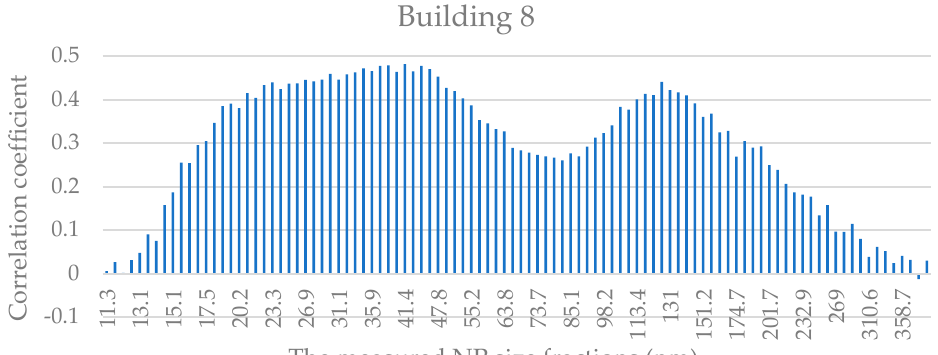
Figure 14. The correlation coefficients (Pearson) between the ventilation flow and the NP number concentration during the one-week measurement period presented for each size fraction in Building 8 during the heating season.